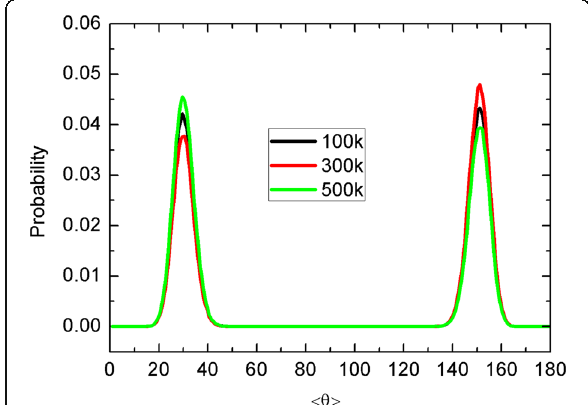
Fig. 5 Probability distribution of the average dipole orientation of water molecules inside the CNT and different sheet temperatures are marked by line colors